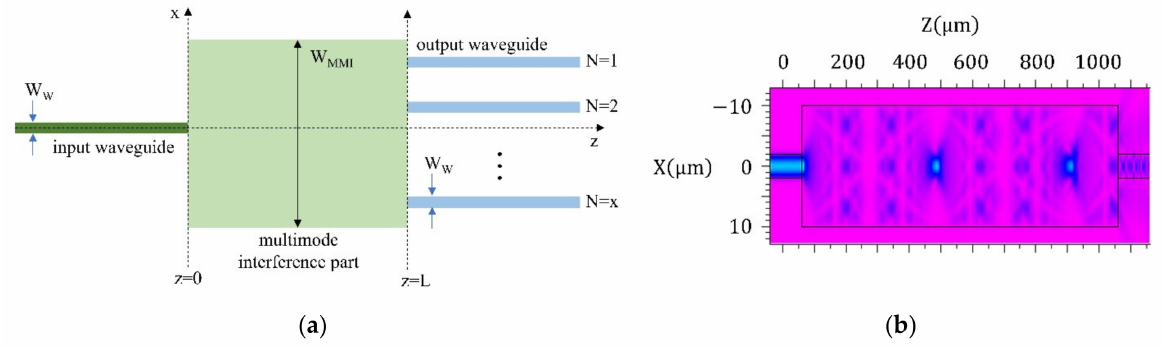
Figure 1. ( a ) Basic arrangement of MMI splitter and ( b ) simulation of electromagnetic wave distribu- tion in the 3D MMI splitter for a (20 × 20) µ m 2 square base taken at the central part of the